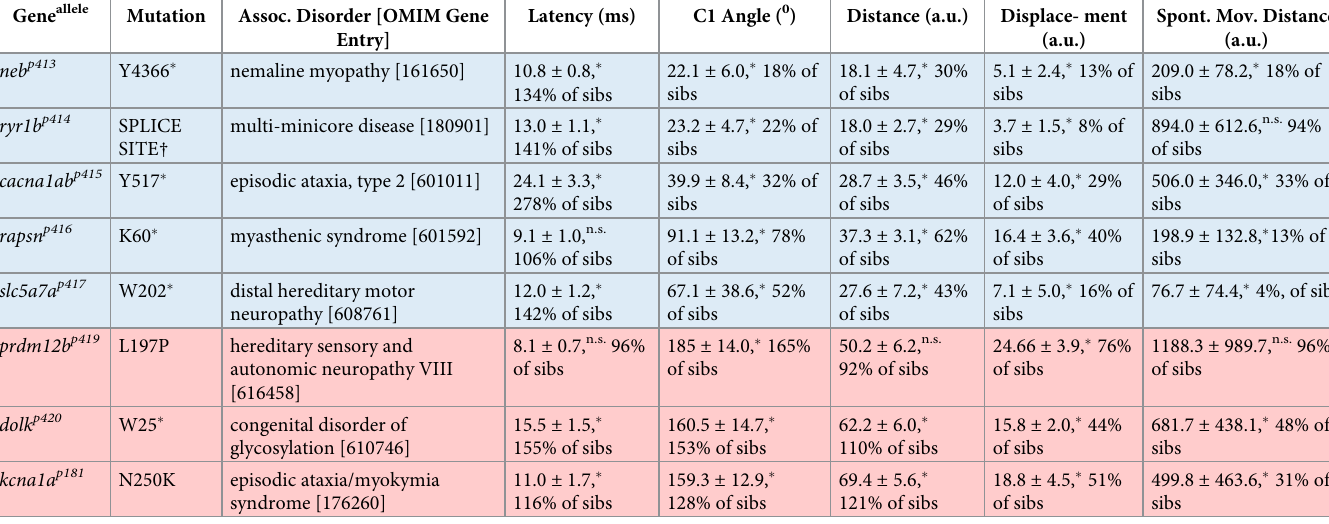
Table 1. Genes identified from a forward genetic screen that regulate locomotor behaviors in larval zebrafish. Gene allele